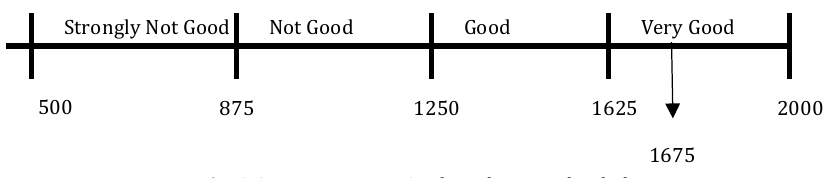
Fig. 1 Continuum Line Quality Photos Uploaded By Travelers (UGC) on Instagram